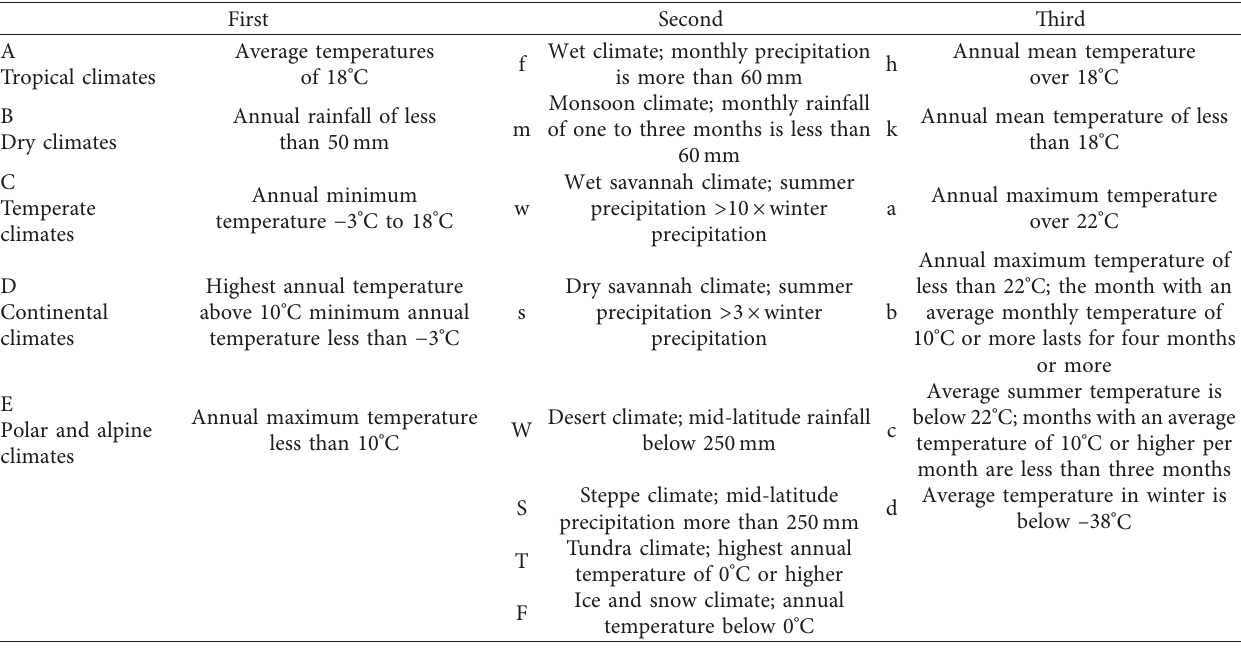
Figure 1: Research procedure. Table 1: K¨oppen–Geiger climatic zones